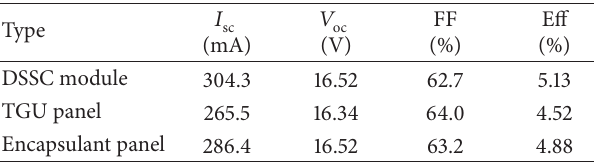
Figure 7: Transmittance of the TGU DSSC panel and the silicone encapsulant DSSC panel. Table 3: Electrical efficiency per panel type and DSSC